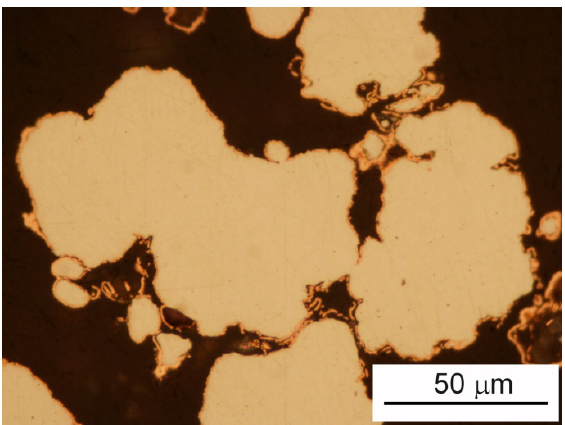
Figure 2. Cross-sections of typical copper-coated iron particles. The content of copper in presented powder is 8 wt.%, LM.